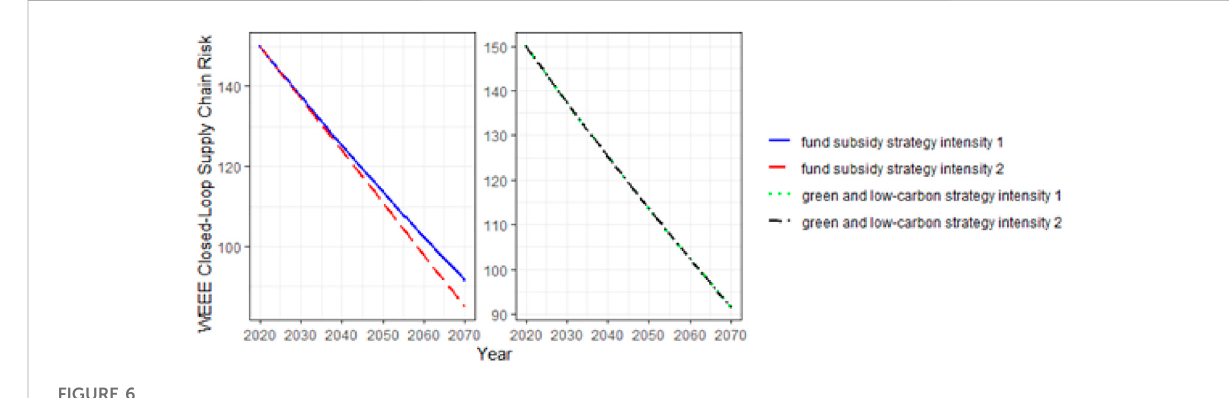
FIGURE 6 Comparison diagram of the risk control